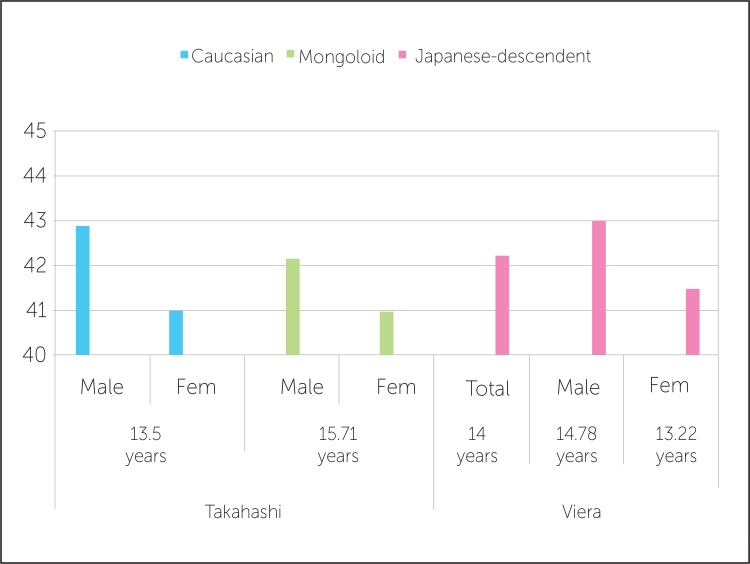
Means of UPFH - TPFH.